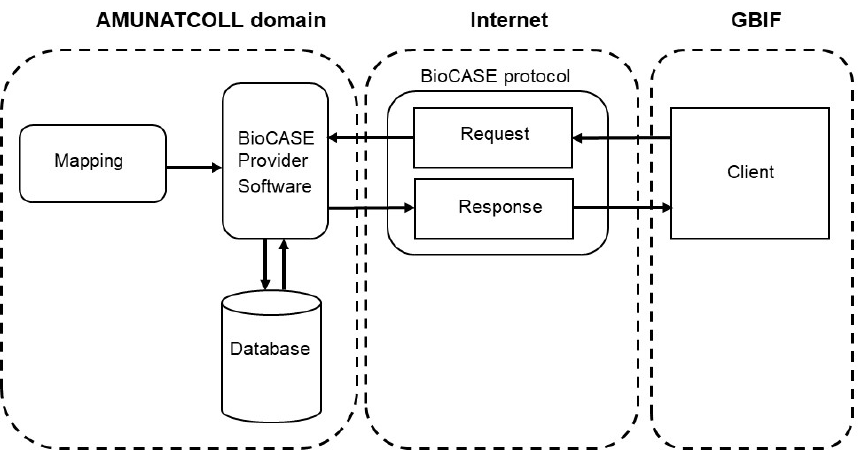
Figure 10. Communication between the AMUNATCOLL IT system and external biodiversity data- bases.